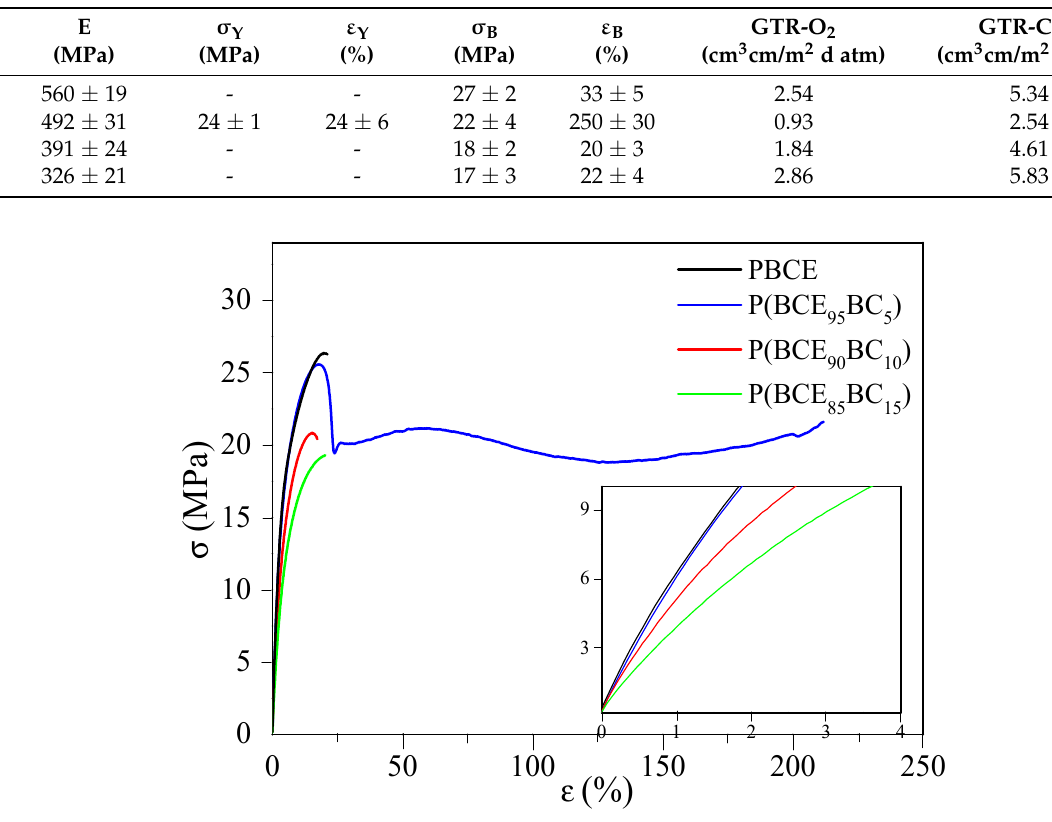
Figure 5. Stress–strain curves of PBCE and P(BCE x BC y ) copolymers.